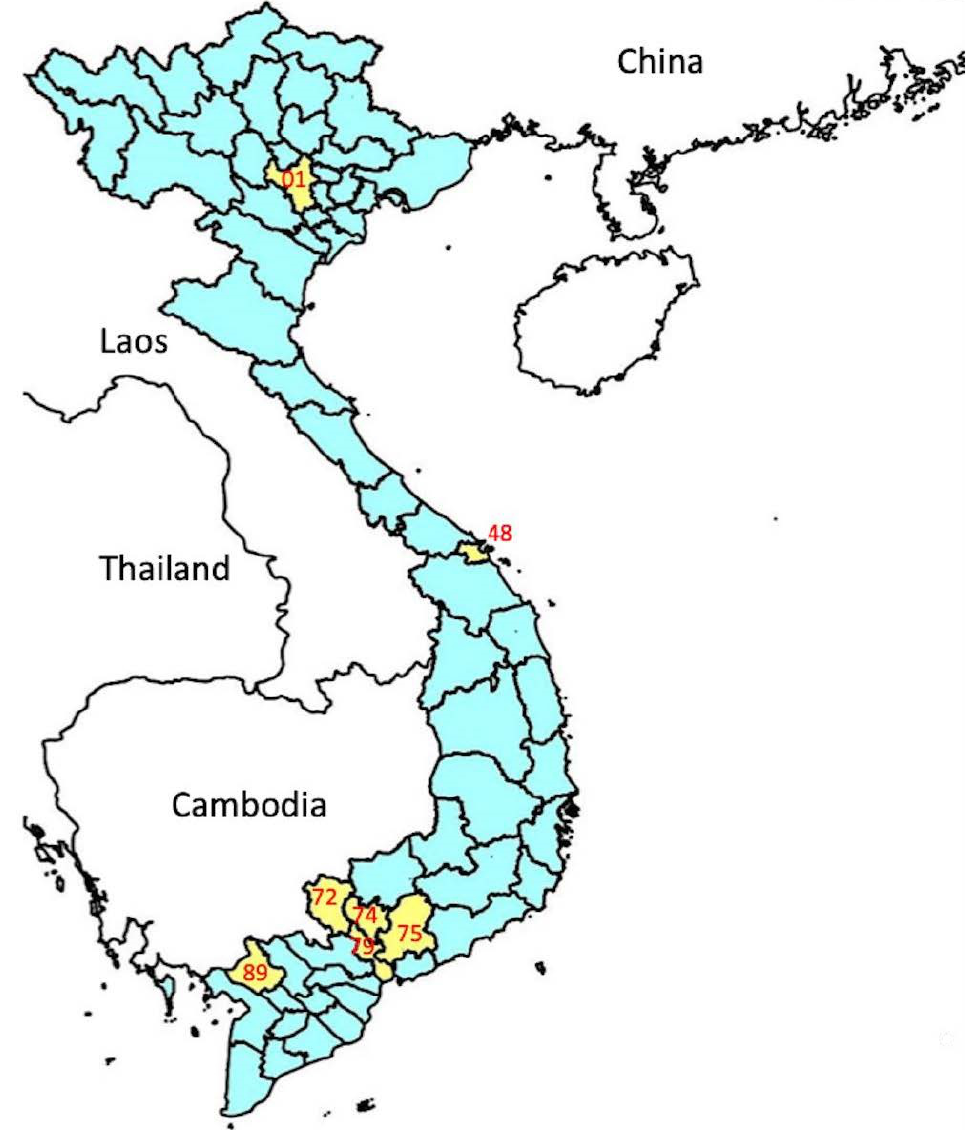
Figure 1. Map of Vietnam with neighboring countries and some of the main affected provinces by COVID-19 in the fourth wave are highlighted in yellow and the province code in red (Ha Noi — 01, Ho Chi Minh — 79, Binh Duong — 74, Dong Nai — 75, An Giang — 89, Tay Ninh — 72, Da Nang — 48).